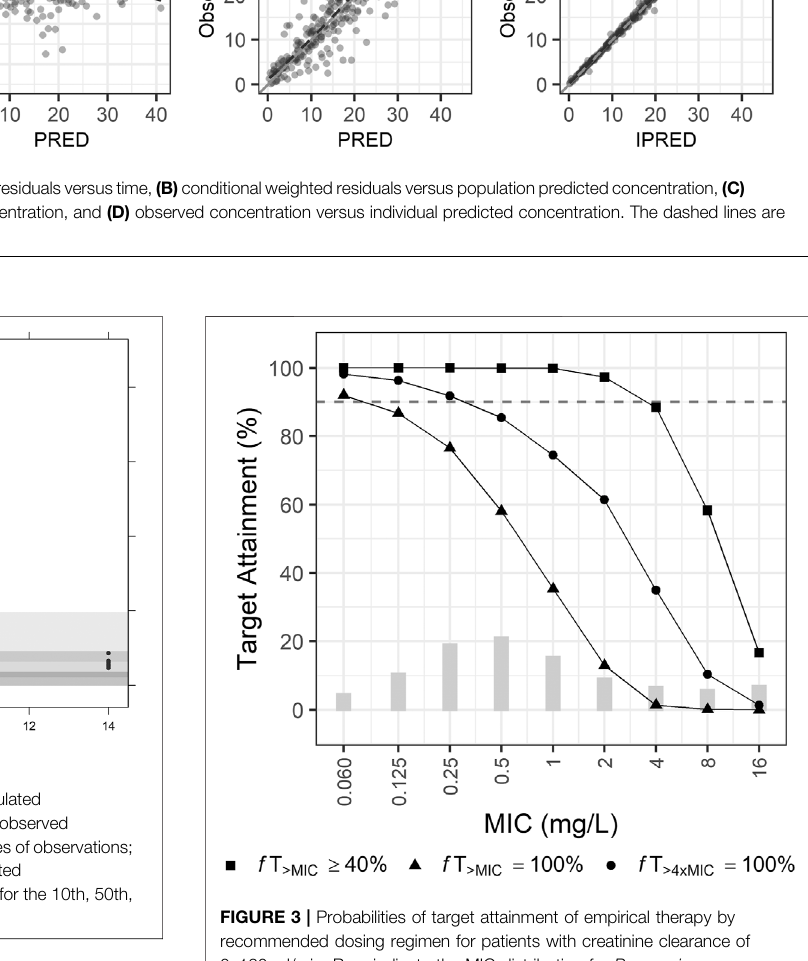
recommended dosing regimen for patients with creatinine clearance of 0 – 130 ml/min. Bars indicate the MIC distribution for P. aeruginosa